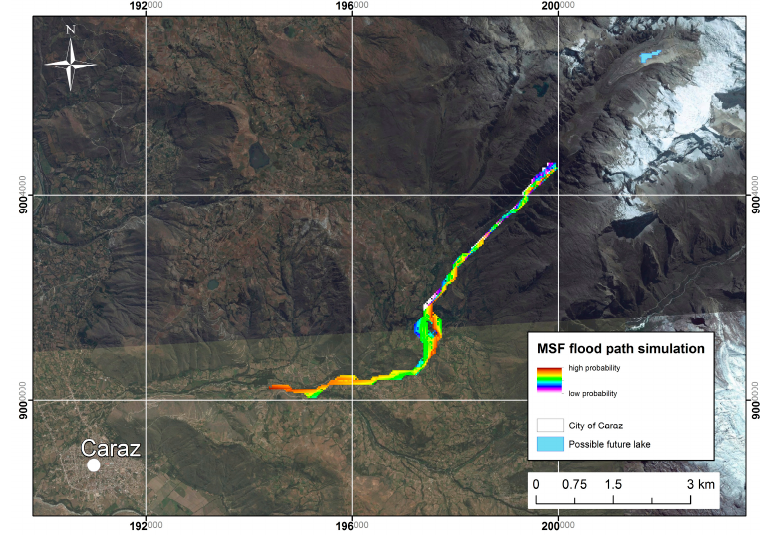
Figure 13. Model run of an outburst flood from a possible future lake (about 380,000 m 3 ; upper right corner of the image) using the modified single flow (MSF) approach. The color scheme indicates probability levels of pixels to be affected. See text for discussion.